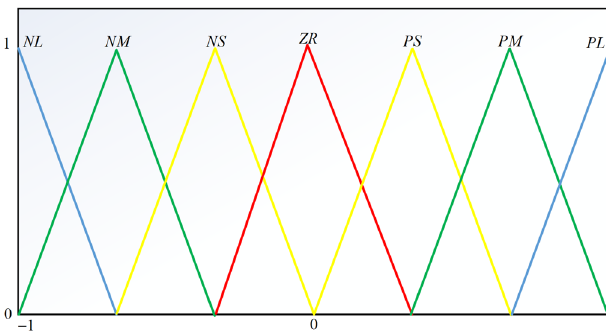
Fig. 12 Membership functions for inputs and outputs of the fuzzy controller